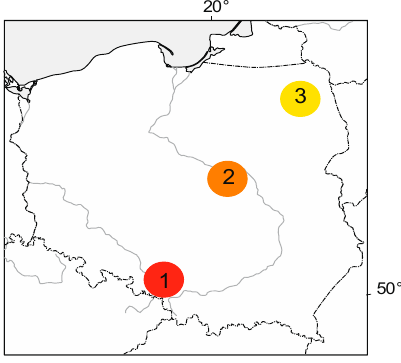
Figure 4. Location of Pleurozium schreberi sampling sites in Poland in 2010 for PAHs analysis. (1) Silesia–Kraków region, (2) Mazovia region and (3) Podlasie region (adapted from [18]). Table 2. Number of samples (N), sum of PAHs (ng kg − 1 d. wt.) and SD calculated for Pleurozium schreberi collected in three regions in Poland. Region N